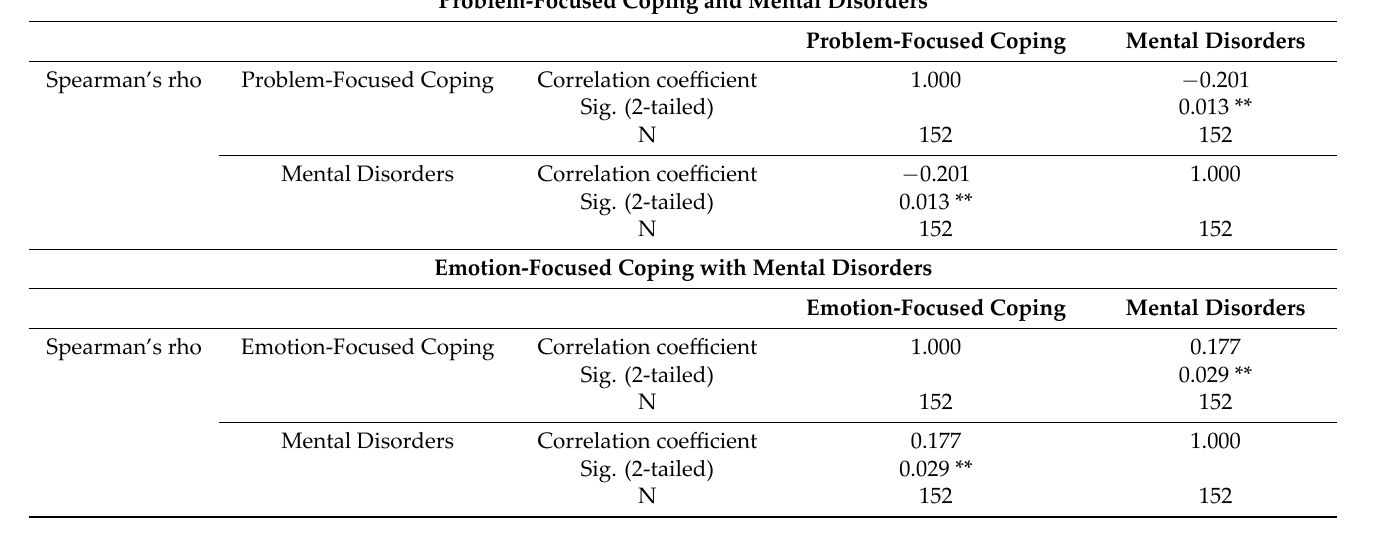
Table 5. Spearman’s rank correlation between different coping styles and mental disorders among the LGBT+ community in